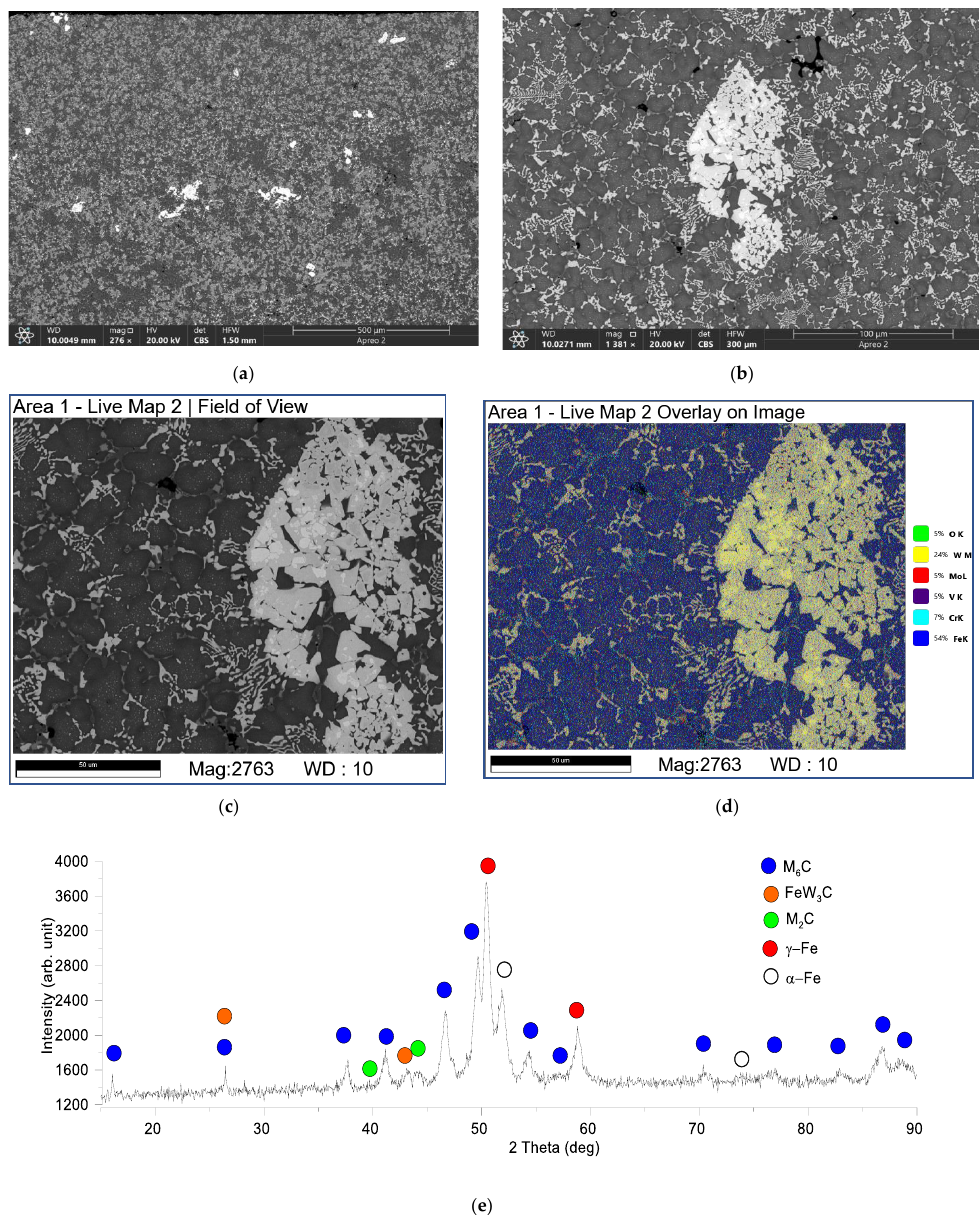
Figure 2. The SEM BSE images ( a – c ) and overlay EDS image ( d ) of the as-clad M2/W coating transverse section. Glancing X-ray diffractograms of initial surface of M2/W coatings ( e ).